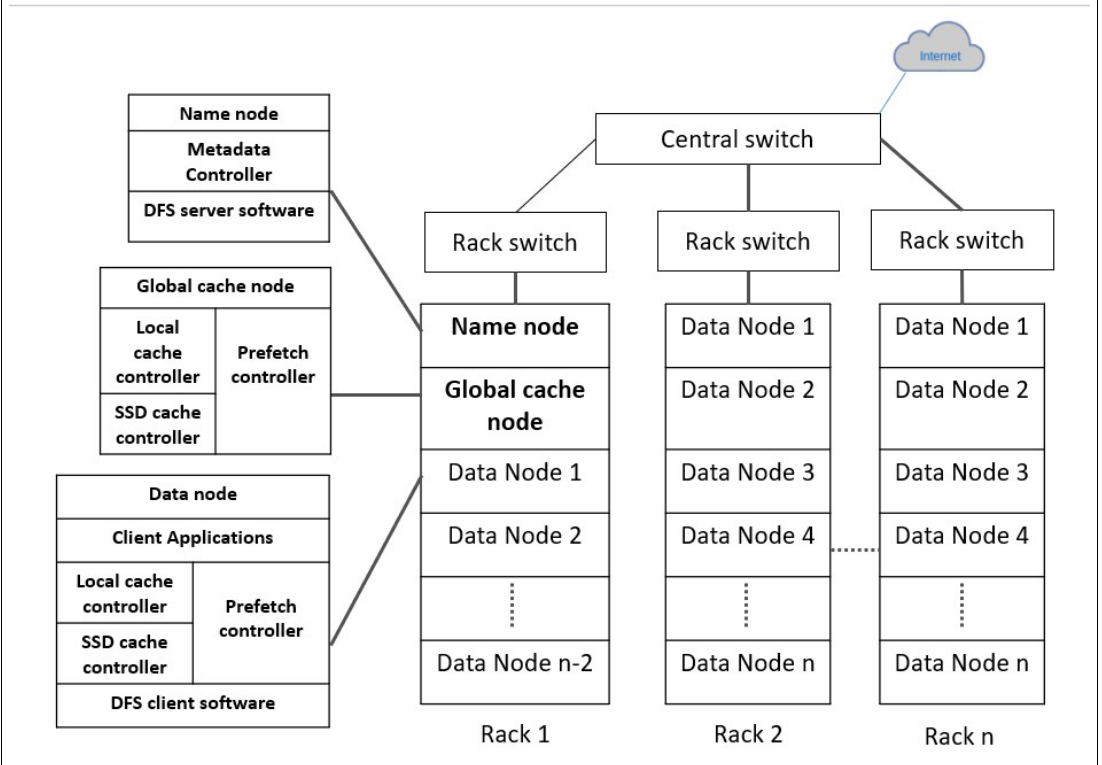
Figure 1. Rack organization of Nnode, Gnode, and